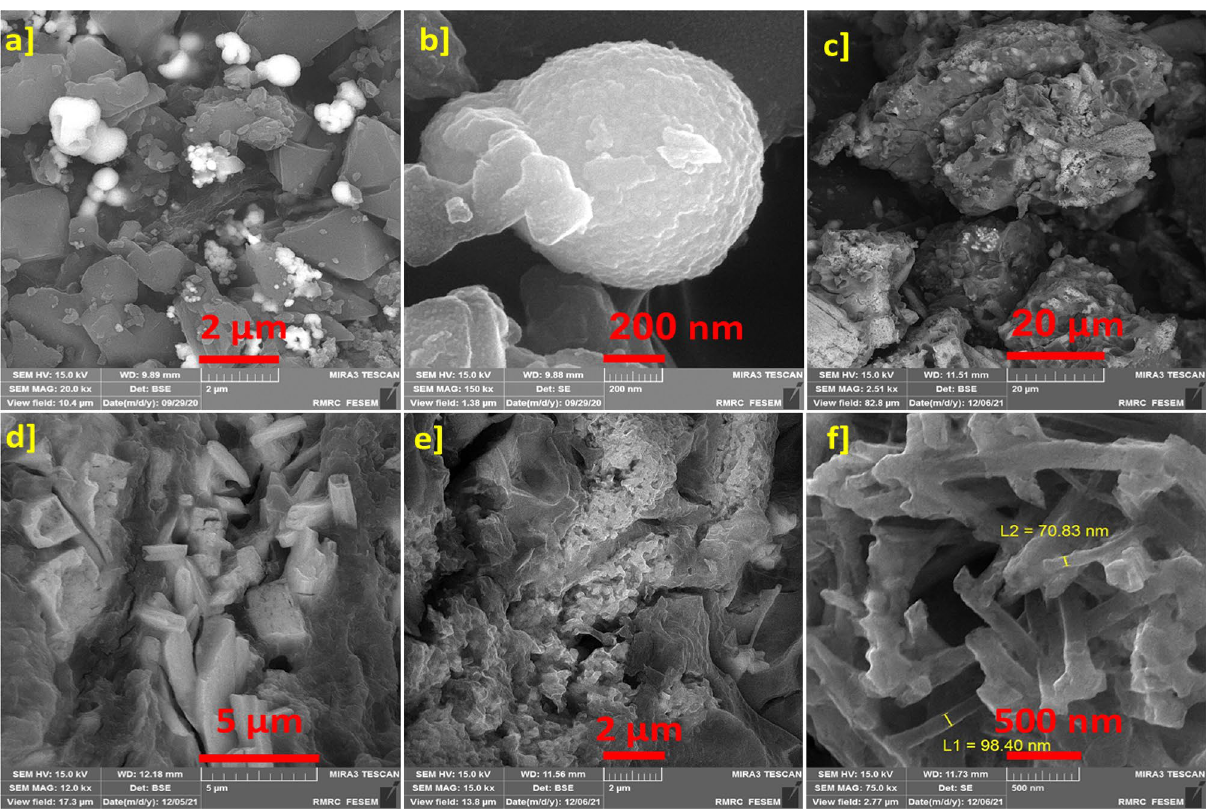
Figure 5. The FE-SEM images of ZnTPP/Cu-NPs (1) ( a , b ) and ZnTPP/Cu-NPs(2) ( c – f ), representing the growth of Cu